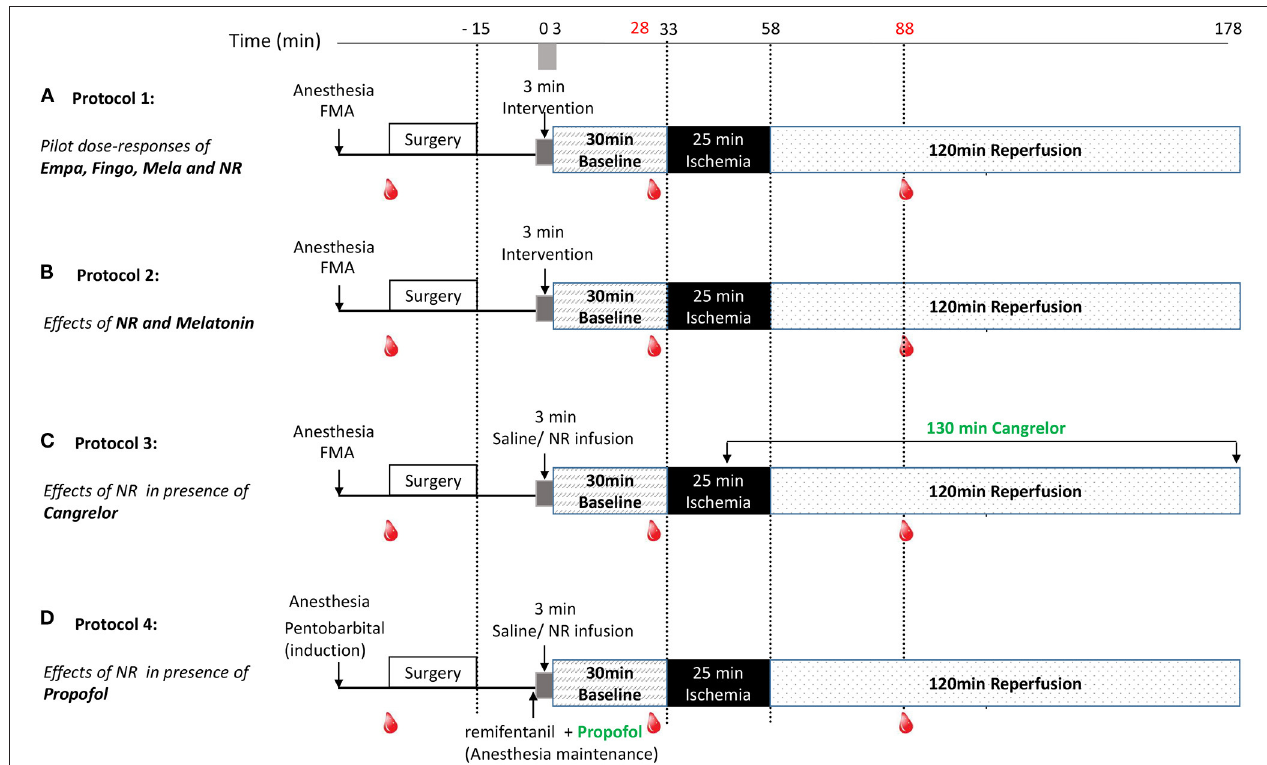
FIGURE 1 | Experimental protocols. Following surgery and 3min drug infusion, rat hearts were subjected to 30min stabilization, 25min ischemia (I) and 120min reperfusion (R). Blood samples were collected before surgery (0.15ml), 5min before ischemia (0.15ml) and 30min after reperfusion (0.15 + 1ml); (A) Protocol 1: For examining dose-responses of Empagliflozin, Fingolimod, nicotinamide riboside (NR) and Melatonin, rats were randomly assigned to 12 groups: saline, 10, 25, or 125 mg/kg empagliflozin, 1, 3, or 10 mg/kg Fingolimod, 100, 500, or 1,000 µ g/kg Melatonin, 50 or 150 mg/kg NR. (B) Protocol 2: For examining NR (50 mg/kg, dissolved in saline) and Melatonin (500 µ g/kg, dissolved in 0.99% ethanol) effects on in vivo IR injury, rats were randomly assigned to 5 groups: saline, saline + ethanol (0.99%), melatonin, NR, and NR + melatonin. (C) Protocol 3: For examining NR effects on in vivo IR injury in presence of cangrelor. Rats were randomly treated with saline or NR (50 mg/kg). Cangrelor (60 µ g/kg) was infused at 10min before reperfusion and maintained (360 µ g/kg/h) until the end of reperfusion; (D) Protocol 4: For examining NR (50 mg/kg) effects on in vivo IR injury in presence of propofol. Rats were randomly treated with saline or NR (50 mg/kg). Anesthesia was induced